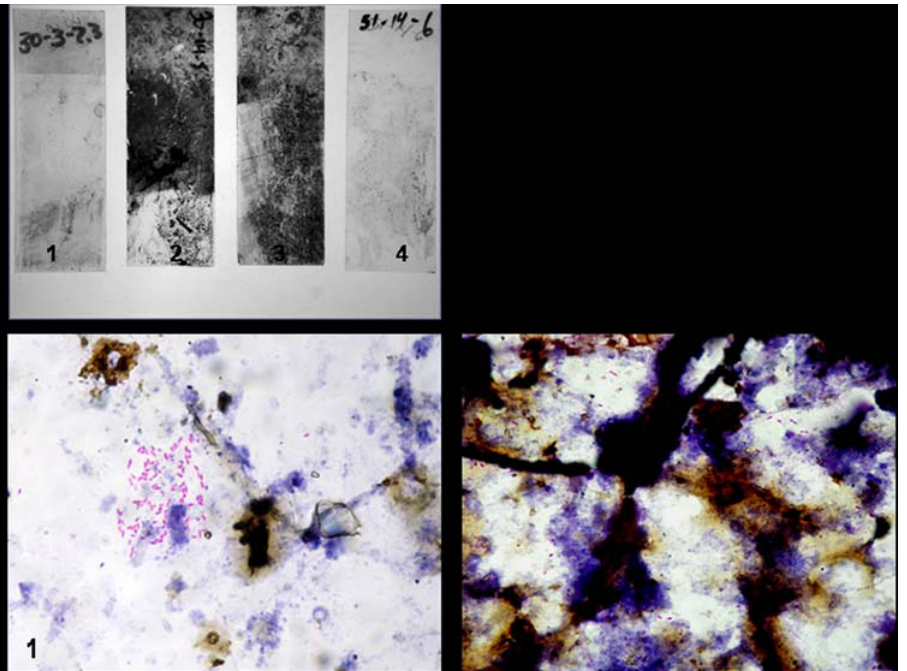
Figure 4. Collection of bacterial biofilms on glass slides from aquatic environments. (A) Slide 1, Adigon: 3 weeks, slide 2, Adigon: 14 weeks, slide 3, Amasaman: 3 weeks, slide 4, Amasaman: 14 wks. (B) 1, Acid-fast stain of bacilli found on a slide in which VNTR profiling matched M. liflandii . 2, Acid-fast stain of bacilli found on a slide in which VNTR profiling matched M. ulcerans . Acid-fast bacilli shown are representative of those found on most collected